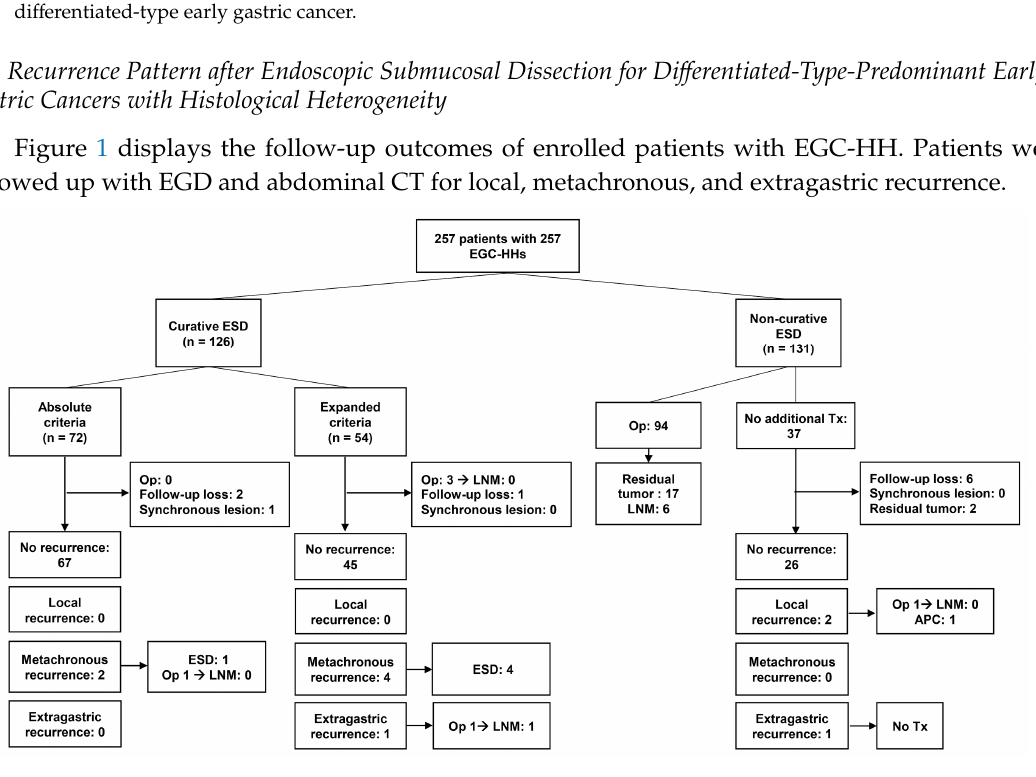
Figure 1. Flowchart for the outcomes of endoscopic submucosal dissection for di ff erentiated-type- predominant early gastric cancer with histological heterogeneity. EGC-HH, di ff erentiated-type- predominant early gastric cancer with histological heterogeneity, ESD, endoscopic submucosal dissection; Op, operation; LNM, lymph node metastasis; Tx, treatment; APC, argon plasma